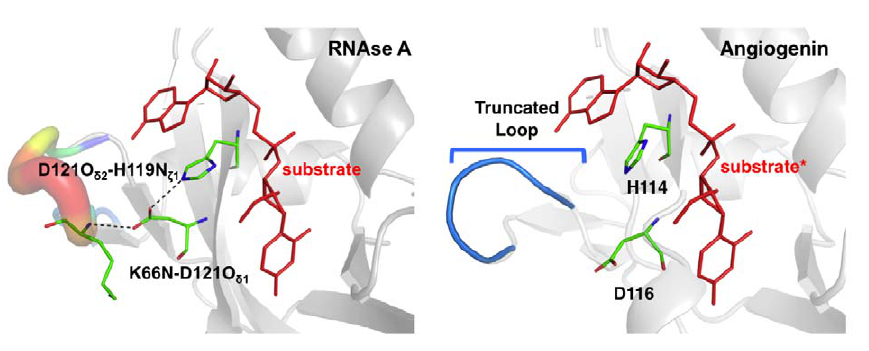
Figure 6. The missing RNaseA network in human angiogenin. Comparison of RNaseA (from B. taurus ) and human angiogenin (based on PDB structure 2ANG and a modeled substrate based on 1U1B, indicated by *) shows similar fold with similar active-site residues; however, angiogenin shows a truncated network loop. This flexible surface loop in RNaseA forms a hydrogen bond with dynamically important network residue D121.